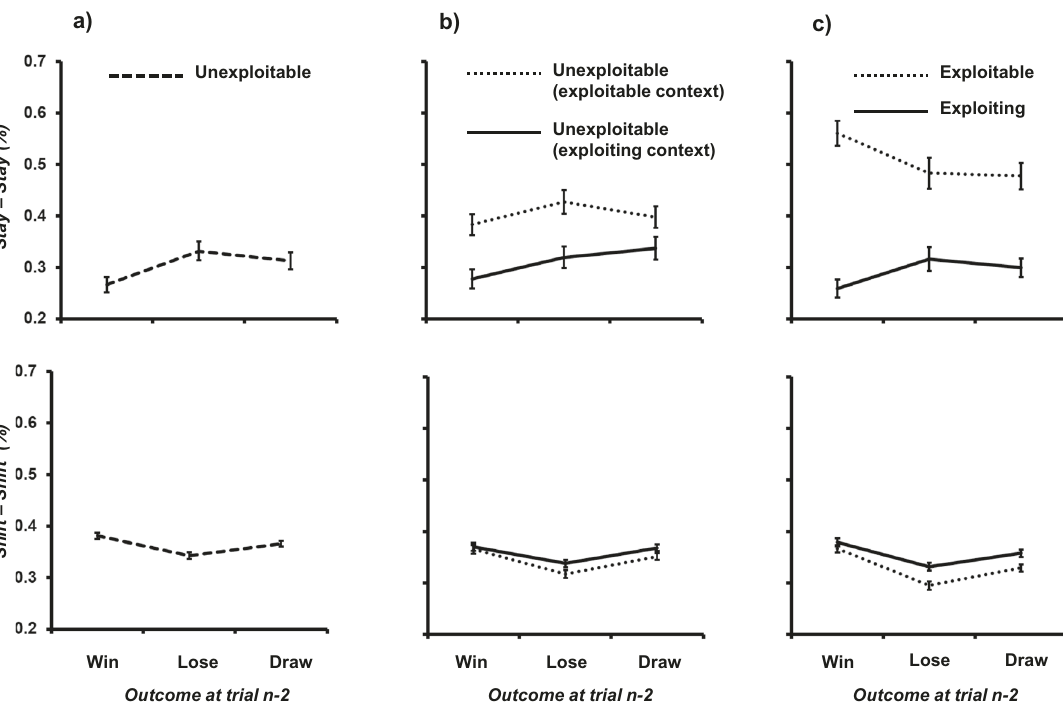
Fig. 1 Proportion of calmness ( stay – stay ) and restlessness ( shift – shift ) behaviour between trial n-2 to n-1 , and, trial n-1 to n as a function of outcome at trial n-2 ( win, lose, draw ), and the nature of opponency. Error bars represent standard error. Group performance is represented when participants engaged with A unexploitable opponents only, B unexploitable opponents in the context of other opponents, and C exploitable and exploiting